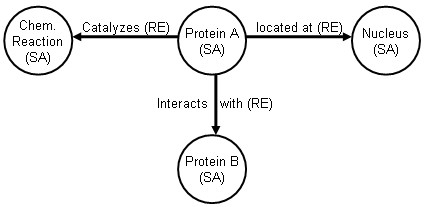
An example of a semantic network. Characteristics and behaviors of a semantic agent (SA) are defined by its relationships (RE) with other agents. Semantic agents are represented as circles, and relationships are depicted as arrows. This SN-model represents that a protein A can be located at a nucleus, can interact with a protein B or catalyze a chemical reaction. For explanatory purpose, this figure illustrates an example of a semantic network. The implemented semantic network (as presented in the paper) is more complex and involves different types of relationships and agents.